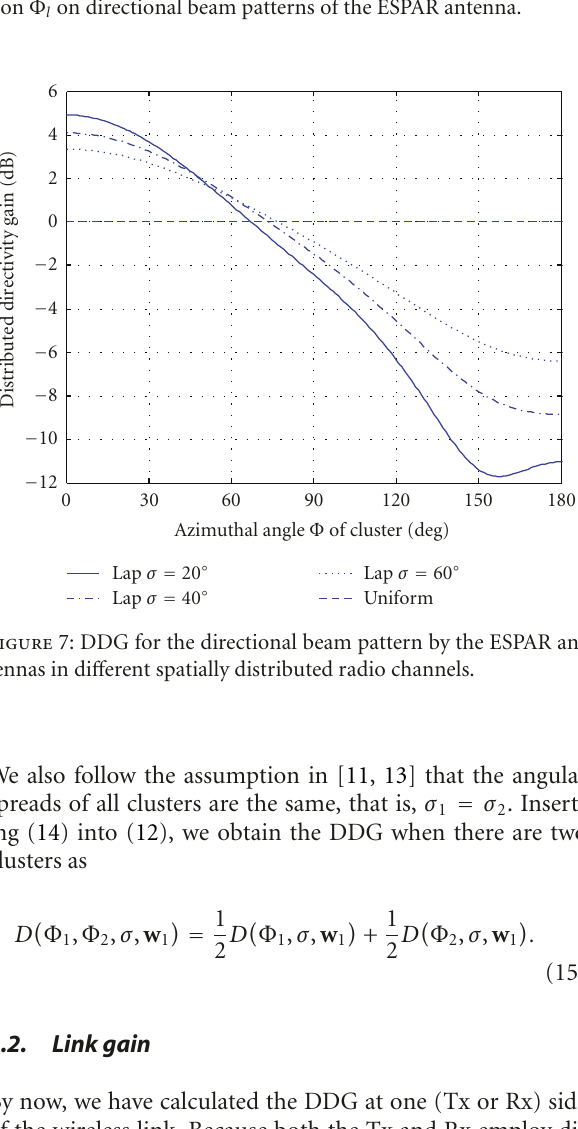
Figure 6: The impinging waves from a cluster with nominal direc- tion Φ l on directional beam patterns of the ESPAR antenna.